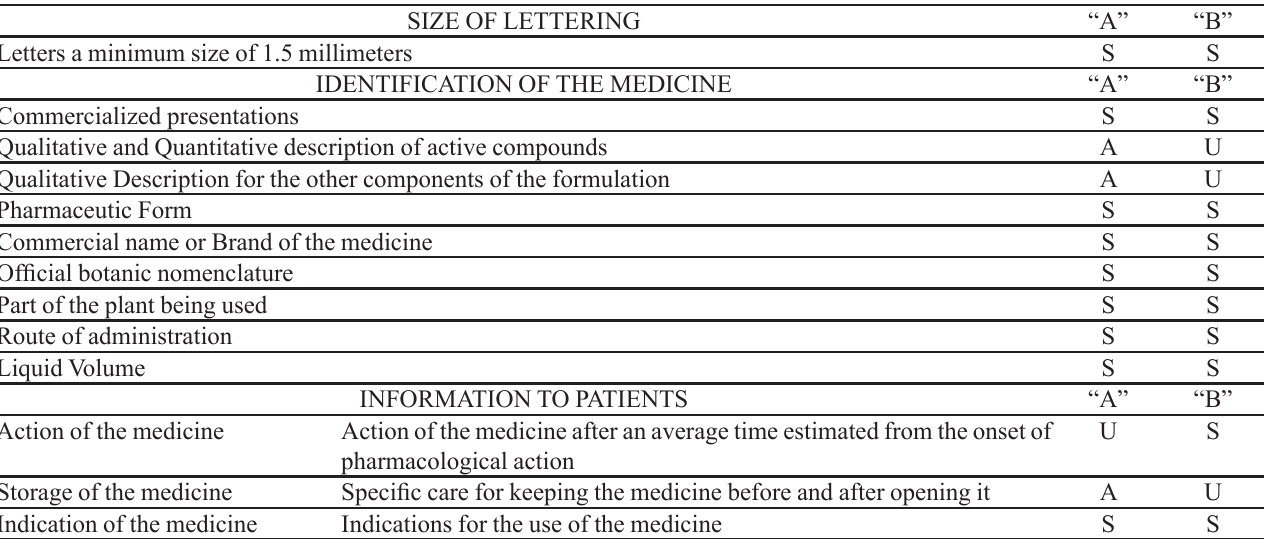
TABLE I – Standard form for evaluation of package inserts according to RDC 140/2003, employed in the verification of package inserts of P. sidoides medicines produced by manufacturers “A” and “B” SIZE OF